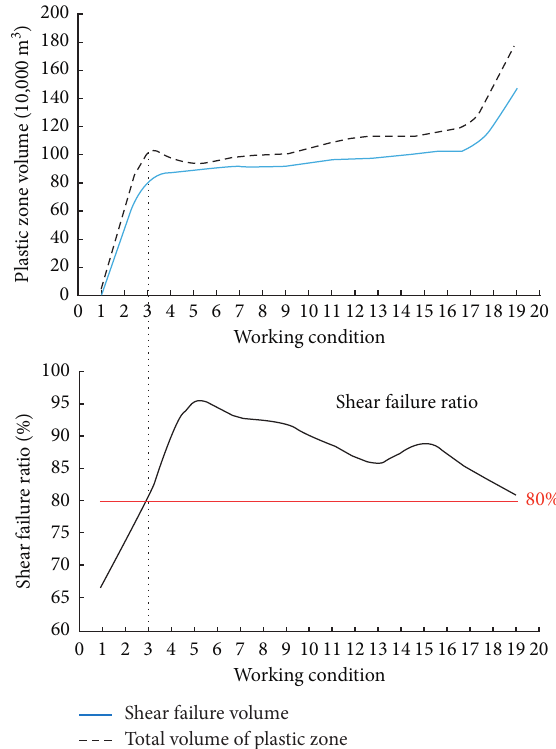
Figure 8: Volume curve of the plastic zone in the rock bridge region.